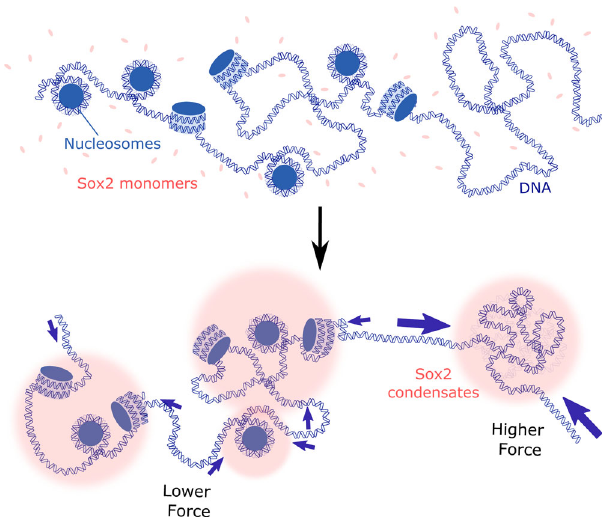
Fig. 6 Working model. Sox2 condensates exert differential mechanical tension within nucleosome-occupied genomic regions versus nucleosome- free regions. Nucleosomes can thus serve as mechanical sinks to regulate the force generated by TF:DNA